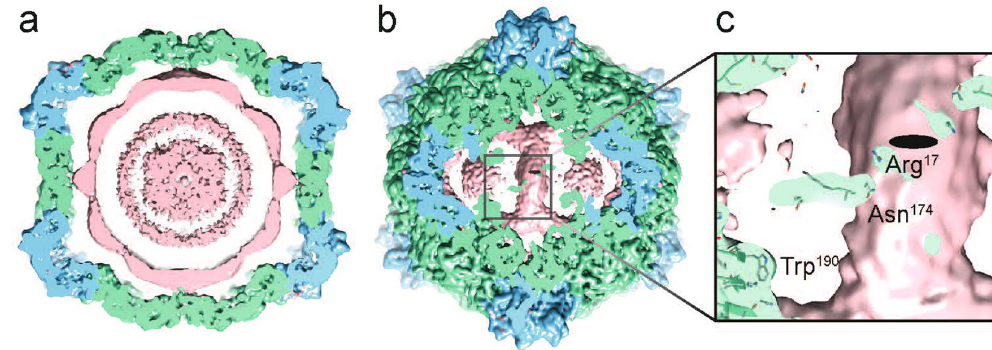
Figure 4. Genome organisation of CPMV-M containing RNA-2. ( a ) A 40 Å thick central slab through the unsharpened CPMV-M EM map (at 4.25 Å resolution; also deposited with the EMD-3565 deposition. Suggested contour level is 0.012). A view down the two-fold axis is shown. The coat proteins are coloured as before with the extra EM density attributed to RNA coloured pink. ( b ) A view beneath the capsid at the two-fold axis showing the strongest density for RNA. ( c ) Zoomed in view to highlight RNA-protein interactions. The strongest density bridges between the capsid and RNA are at amino acids Asn174 and Arg17 from the L subunit. Trp190 binds strongly to RNA in CPMV-B virions (containing RNA-1), here we can see no density between Trp190 and the EM density attributed to RNA-2.